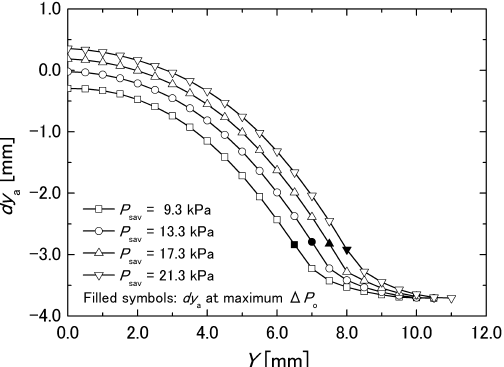
Fig. 7 Relationship between indentation Y and time-averaged displacement of vessel wall under the center of the sensor dy a .